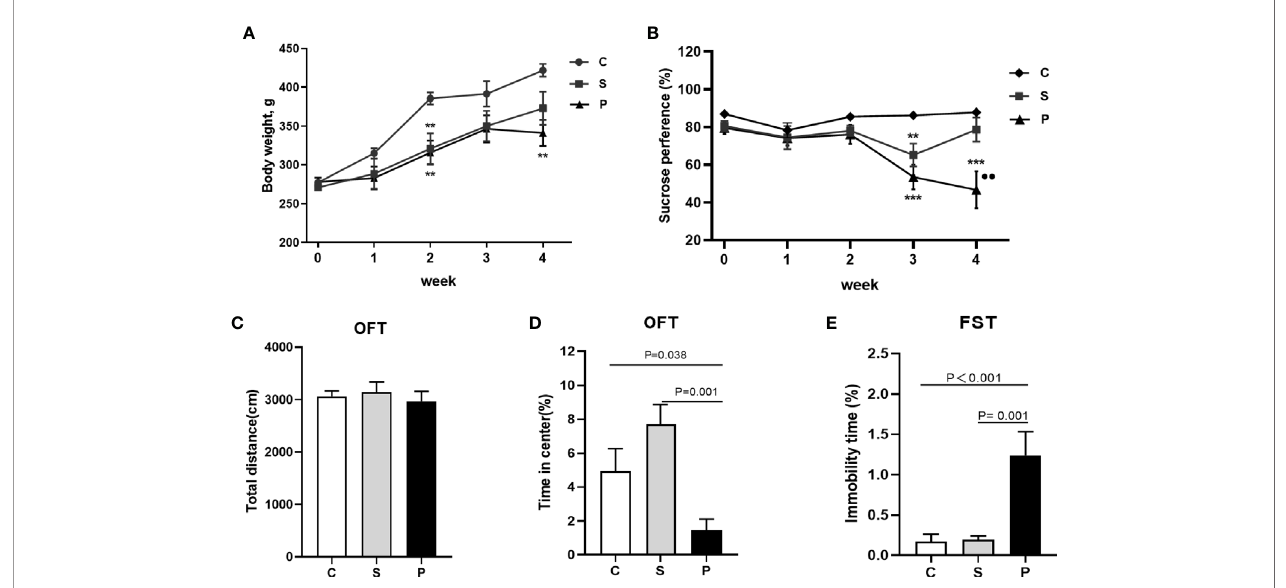
FIGURE 2 | Body weight and behavioral tests. (A) Body weight during CUMS of three group (n = 8 per group); (B) Sucrose preference during CUMS of three group (n = 8 per group); (C) The total distance of OFT was no signi fi cant difference among 3 groups after a 4-week CUMS exposure (n = 8 per group); (D) Percentage of duration time spent in the center square of OFT was compared among 3 groups after a 4-week CUMS exposure (n = 8 per group); (E) Immobility time comparison of FST among 3 groups after a 4-week CUMS exposure (n = 8 per group); C, Control; S, Stroke; P, PSD; PSD group vs. control group, **P < 0.01 and ***P < 0.001; PSD group vs. stroke group, ●● P < 0.01; SPT, sucrose preference test; OFT, Open fi eld test; FST, Forced swimming